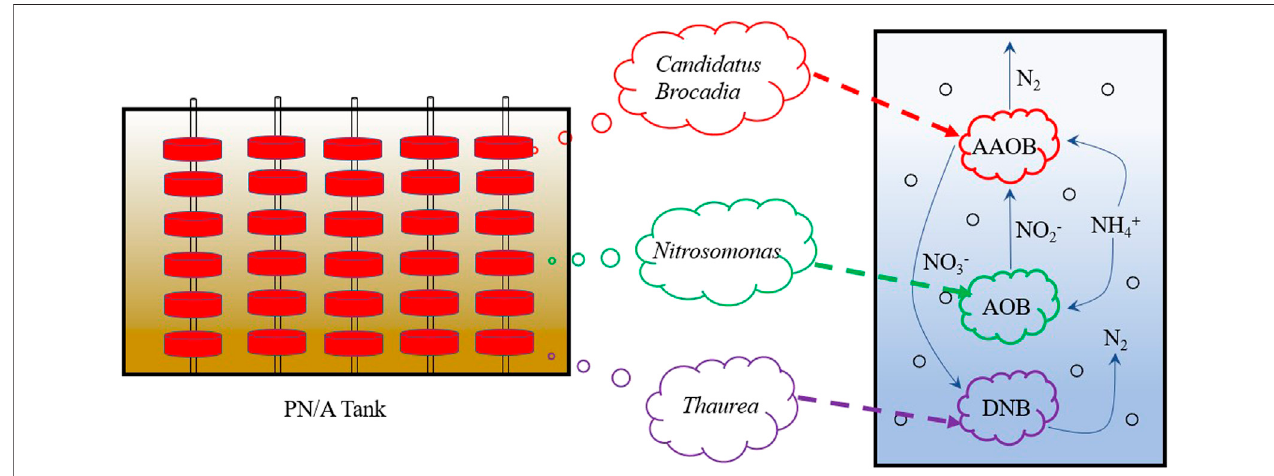
FIGURE 6 | Synergistic microbial nitrogen removal process in PN/A system. The red line represents bio fi lm sludge, green line represents suspended sludge, and purple line represents wasted sludge. PN/A means partial nitri fi cation and anammox.